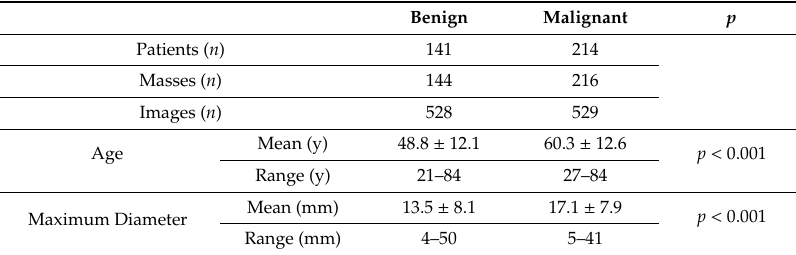
Table 1. Characteristics of patients and their